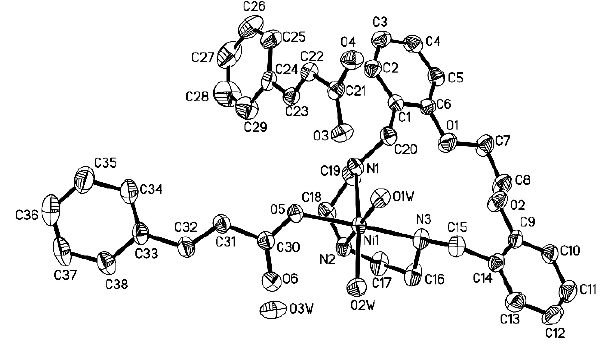
Table 2. Atomic coordinates and displacement parameters (in Å 2 )